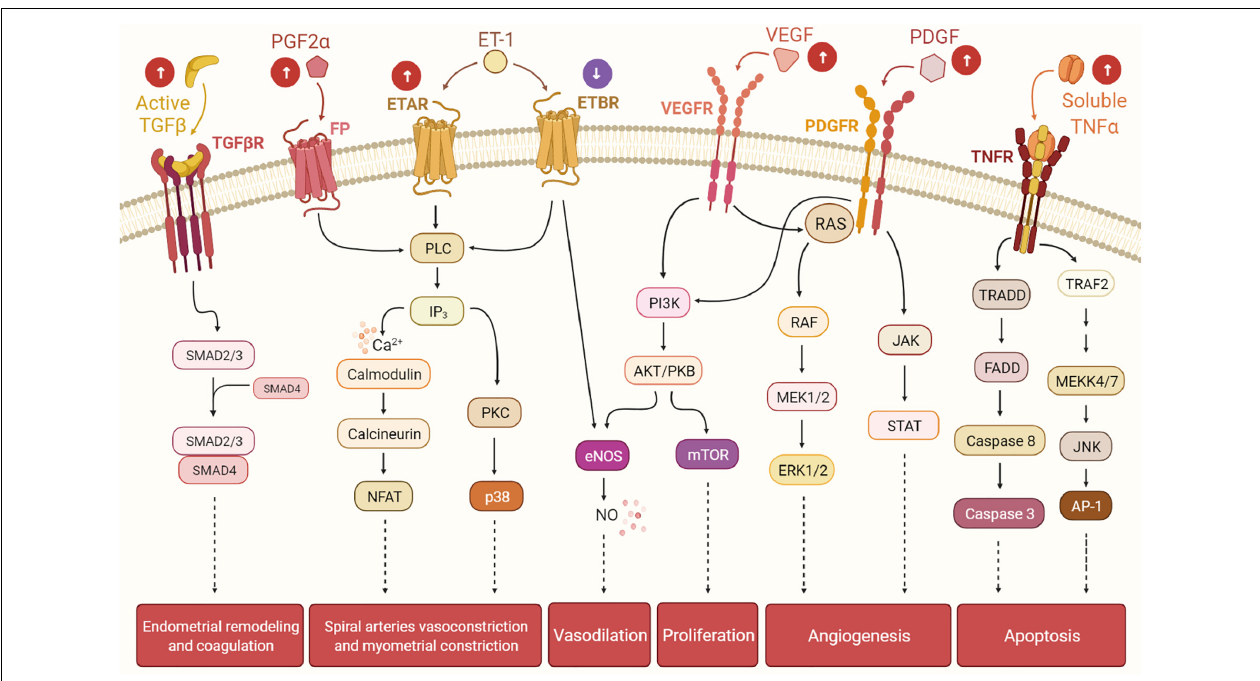
FIGURE 2 | The presence of uterine fibroids (UFs) may interfere with the endometrial pathways involved in the menstrual cycle, leading to heavy menstrual bleeding. Balance among hormones, growth factors, cytokines, and other factors regulates the cyclic endometrial growth and bleeding. Transforming growth factor-beta (TGF- β ), its receptors (TGF- β R), and downstream SMADs are important for endometrial remodeling during menses, and excessive levels of these factors may suppress the gene expressions of the fibrinolytic and anticoagulant components. Prostaglandin F2 α (PGF2 α ) and endothelin-1 (ET-1) are involved in spiral artery vasoconstriction and myometrial constriction during the menstruation period. Vascular endothelial growth factor (VEGF), the most specific endothelial cell growth factor, and platelet-derived growth factor (PDGF) play a role in endometrial angiogenesis, an essential process of endometrial renewal. Nitric oxide (NO) is produced downstream of ET-1 and VEGF signaling, and it is a potent vasodilator. Tumor necrosis factor-alpha (TNF- α ) contributes to the process of menstrual shedding and bleeding through the induction of apoptosis. White arrows within circles indicate uterine changes due to UFs presence, which may dysregulate normal endometrium activity, causing excessive endometrium development and, eventually, heavy menstrual